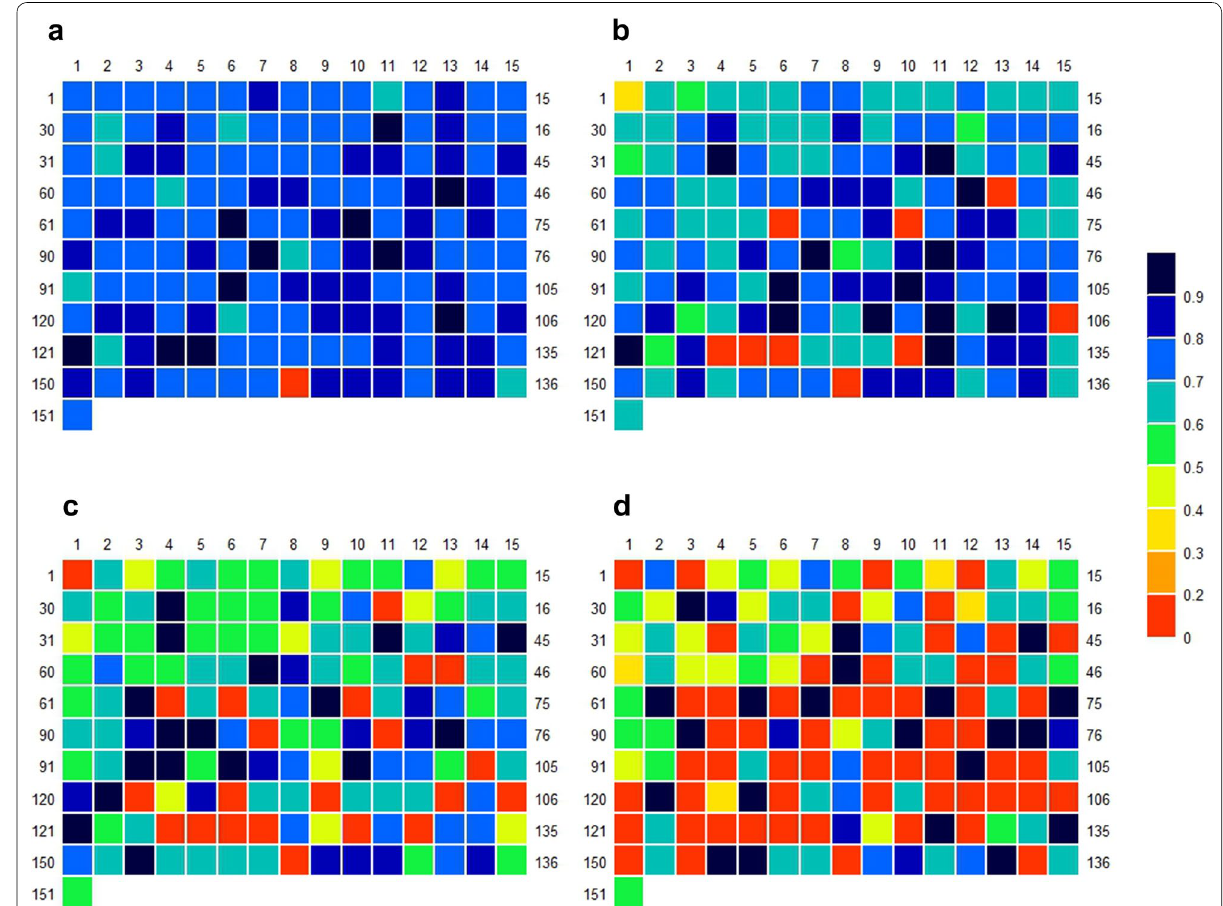
Fig. 6 Clustering coefficient values for annual streamflow network from the Mississippi River basin for four different thresholds ( T ): a T T 0.6; c T 0.7; and d T 0.8. Each box represents a node = = =